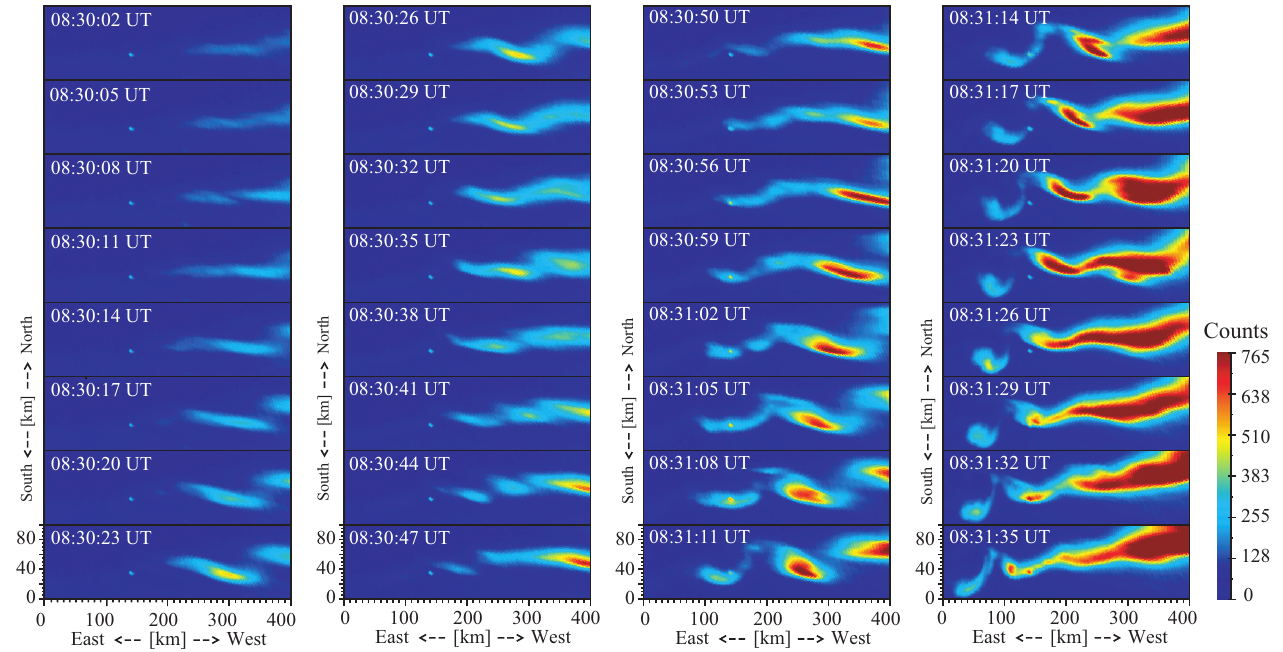
Fig. 5. Brightening auroral images every 3 s observed at 08:30:02–08:31:35UT at Fort Smith on 8 January 2008. These images are averages over